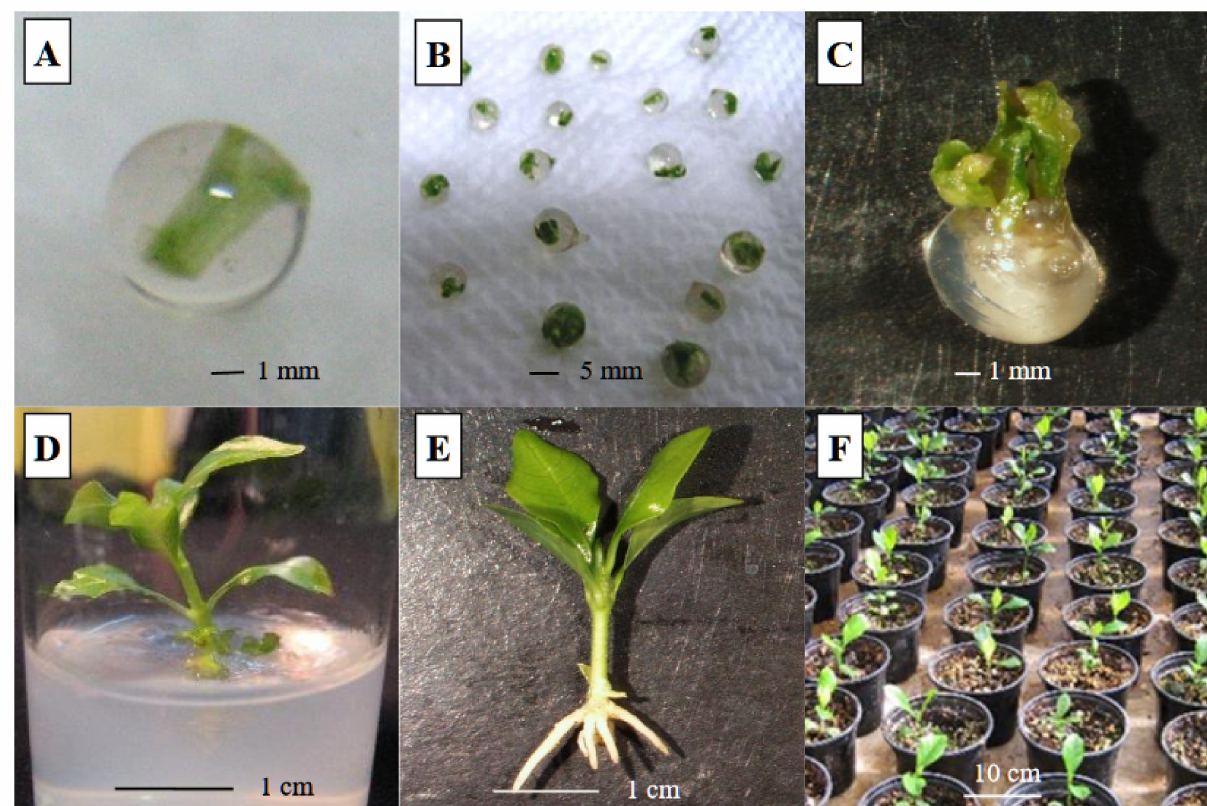
Figure 2. Artificial seed production of G. jasminoides , germination after cold storage and conversion into plantlets: ( A ) encap- sulated nodal segment in 2.5% sodium alginate followed by hardening in 100 mM calcium chloride for 30 min. ( B ) Artificial seeds during storage at 4 ◦ C. ( C ) Germination of cold-stored (for 12 weeks at 4 ◦ C) artificial seed (encapsulated shoot tip), after 10 days on MS nutrient medium. ( D ) Shoot, derived from germinated artificial seed of cold storage, 10 days after placing for rooting in agar-solidified MS nutrient medium with 0.5 µ M IAA. ( E ) Rooted shoot after removal from the agar-solidified MS nutrient medium and before transplanting to peat–perlite substrate. ( F ) Gardenia plantlets established in the greenhouse, after being acclimatized under 75% shading of weekly reduction, 2 weeks from the end of the acclimatization